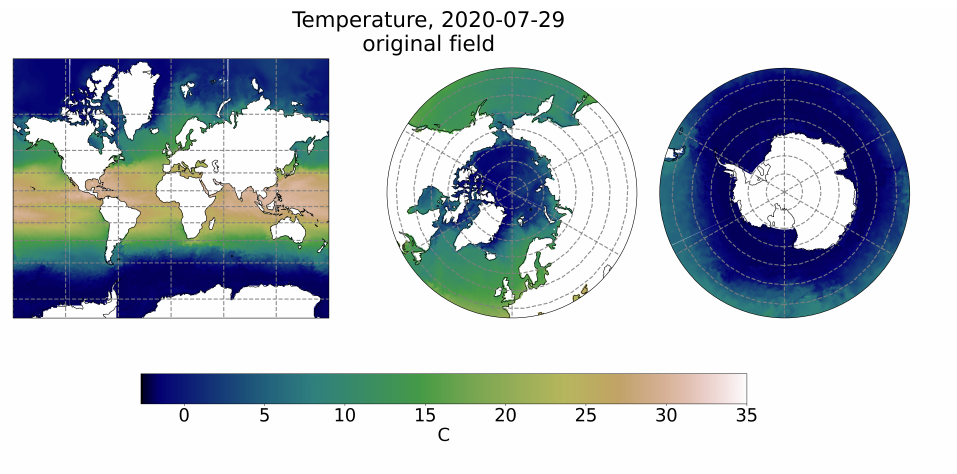
Figure 7. Original temperature field from the test set at 9 m depth, 29 July 2020.